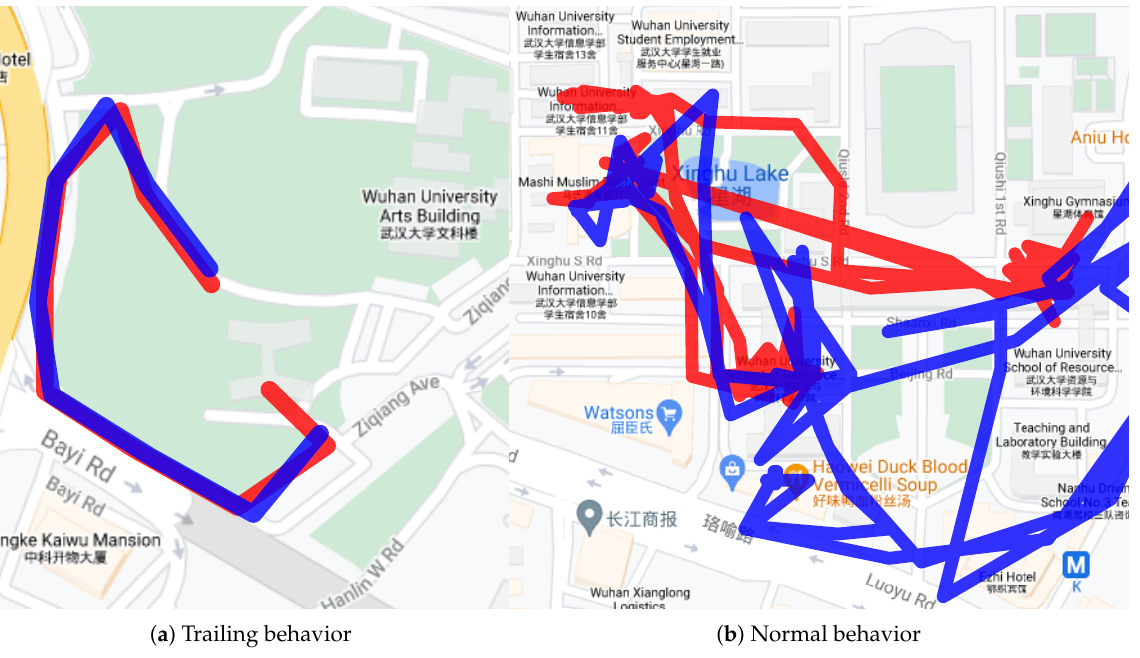
Figure 9. The example of trailing